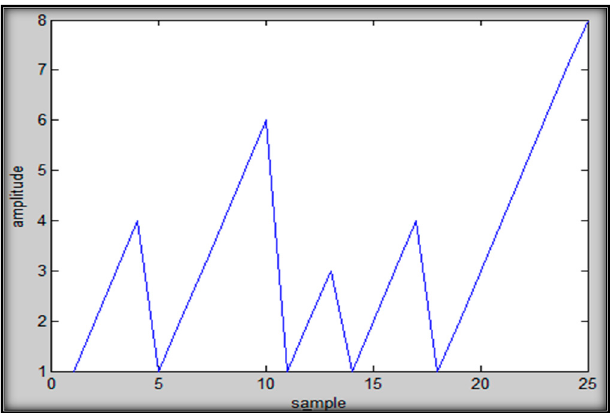
Figure 15. No synchronization. Synchronization bugs were also simulated in code composer studio software to vali- date the proposed approach. The results are shown in Figure 16.